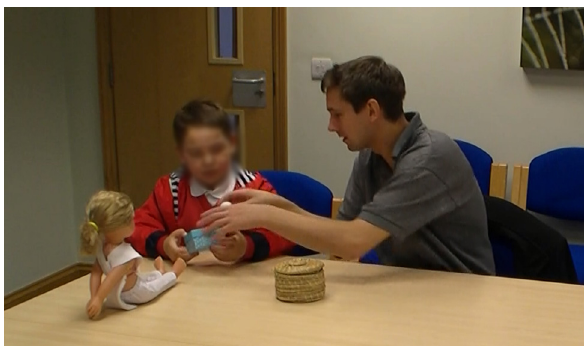
Figure 3: A researcher administering the Sally – Anne test.